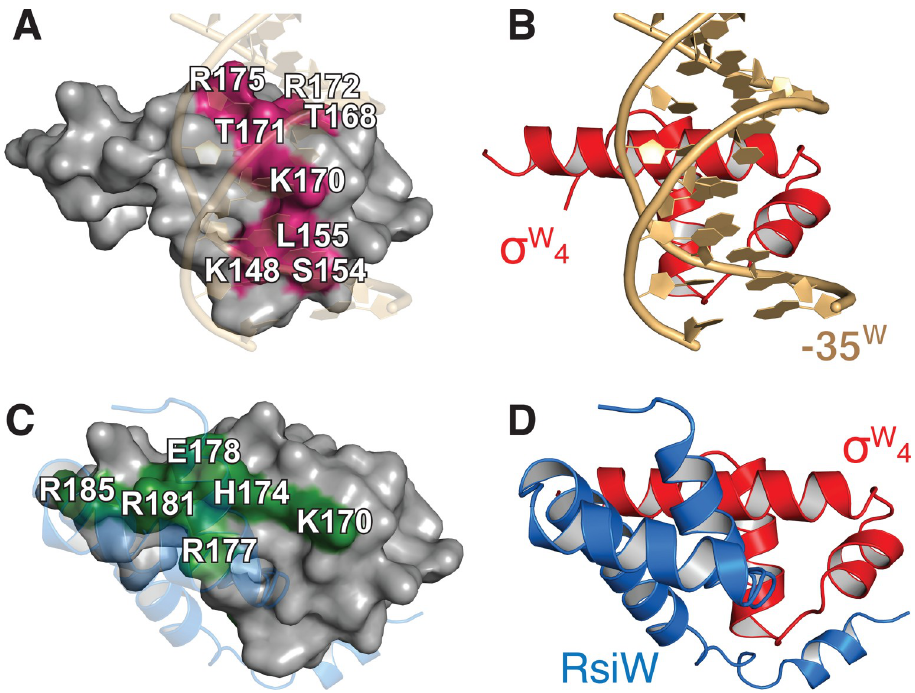
Fig 4. Structural comparison of σ W 4 /-35 W and SigW/RsiW. (A) Surface model of σ W 4 bound to -35 W . The magenta surface indicates the -35 W binding interface. Residues on the binding surface are labeled. (B) Ribbon model of σ W 4 /- 35 W structure. (C) Surface model of σ W 4 bound to RsiW. The RsiW binding surface is colored green, and the residues are labeled. (D) Ribbon model of σ W 4 bound to RsiW. σ W 4 structures in (A)-(D) are drawn at the same orientation.